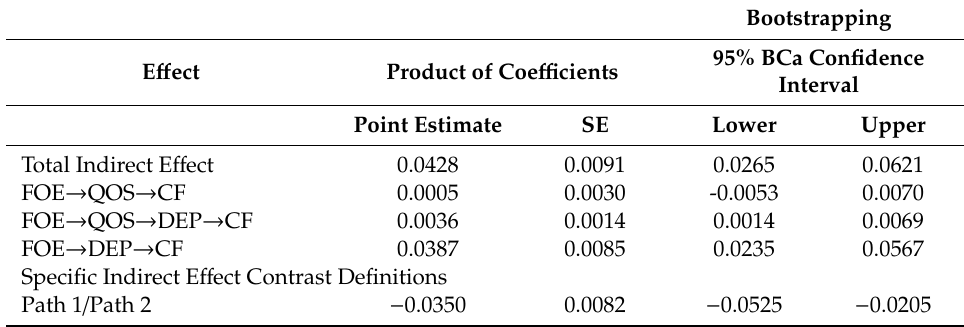
Table 2. Specific indirect e ff ects of frequency of exercise through depression and quality of sleep on cognitive function. Bootstrapping E ff ect Product of Coe ffi cients 95% BCa Confidence Interval Point Estimate SE Lower Upper Total Indirect E ff ect 0.1784 0.0543 0.1038 0.3158 FOE → DEP → CF 0.1762 0.0531 0.1034 0.3143 FOE → DEP → QOS → CF 0.0009 0.0055 − 0.0097 0.0122 FOE → QOS → CF 0.0013 0.0084 − 0.0125 0.0232